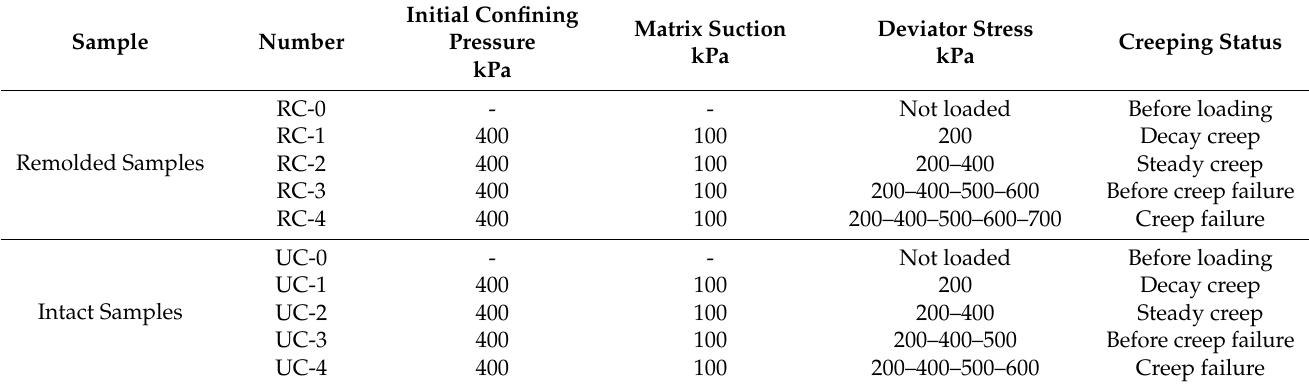
Table 2. Loess sample number and test